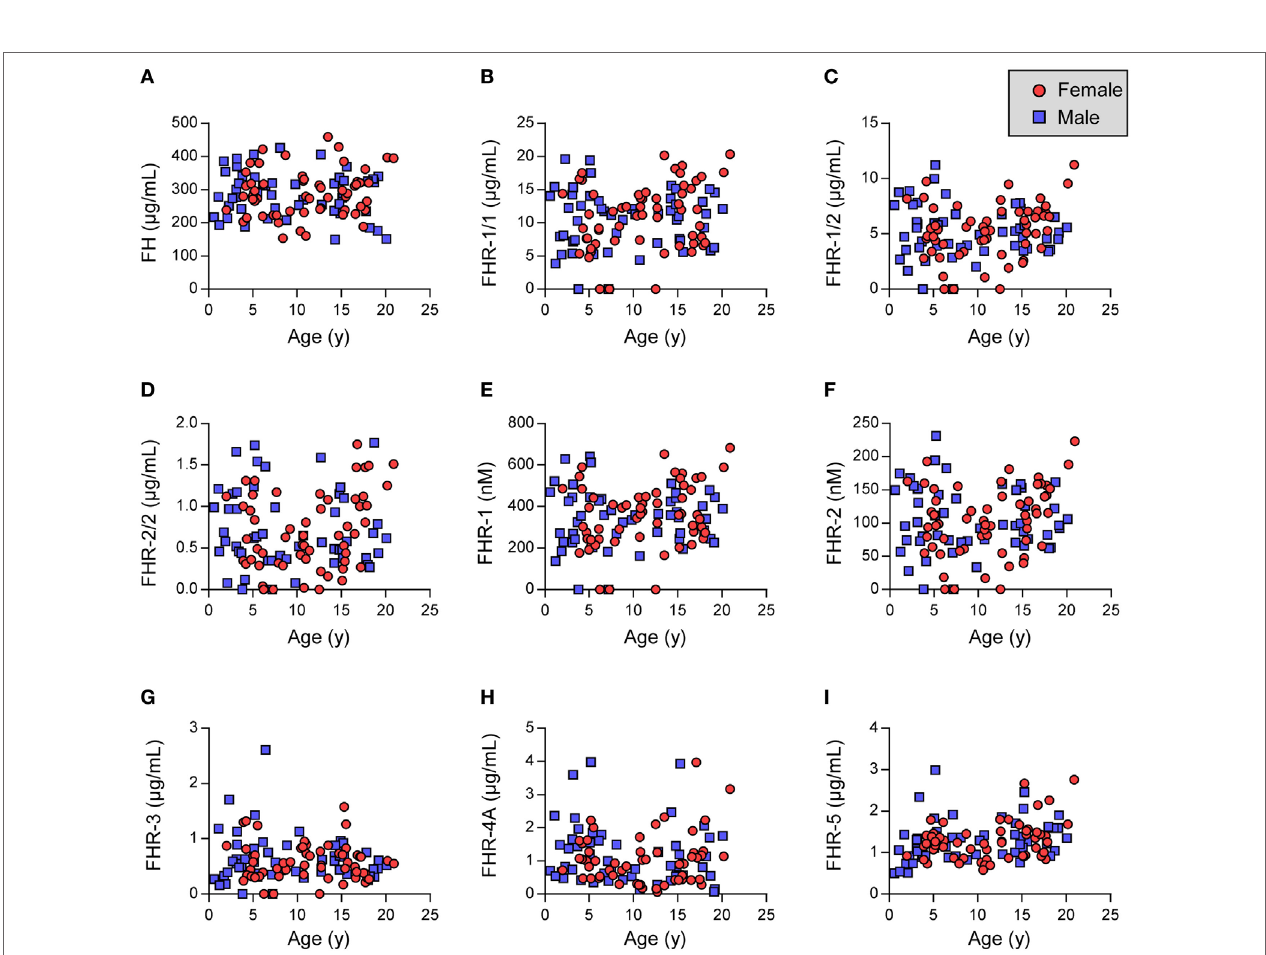
FigUre 1 | Factor H (FH) family proteins in healthy children. (a–c,g–i) Show FH and FHRs as assessed by in-house ELISA. (D–F) Indicate calculated FHR-1 and FHR-2 levels. (D,F) Samples lacking FHR-1 (likely CFHR1 deficient) were excluded. Females are indicated by red circles, males by blue squares. Data were analyzed using Pearson’s correlation and unpaired t -tests ( Table 2